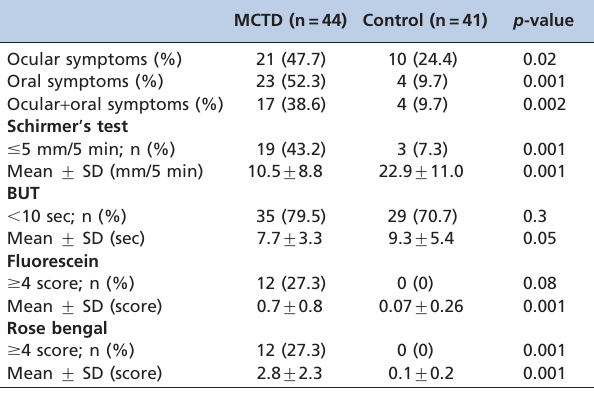
Table 1 - Sicca symptoms and dry eye evaluation in MCTD patients and controls.